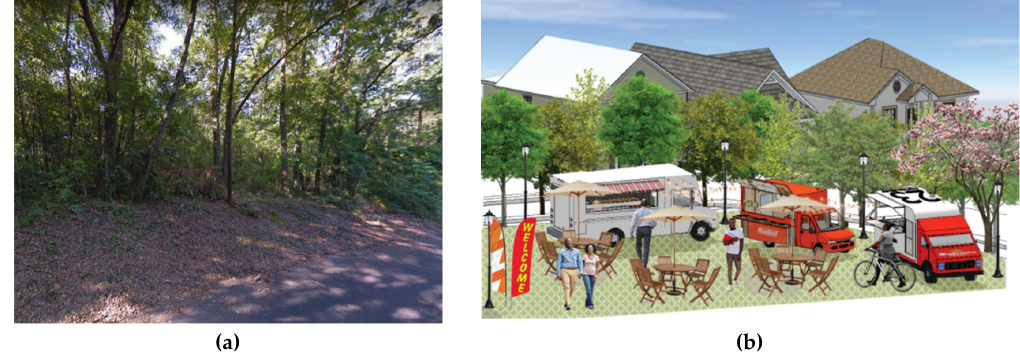
Figure 9. Pop up food trucks: before: (a); and after: (b).